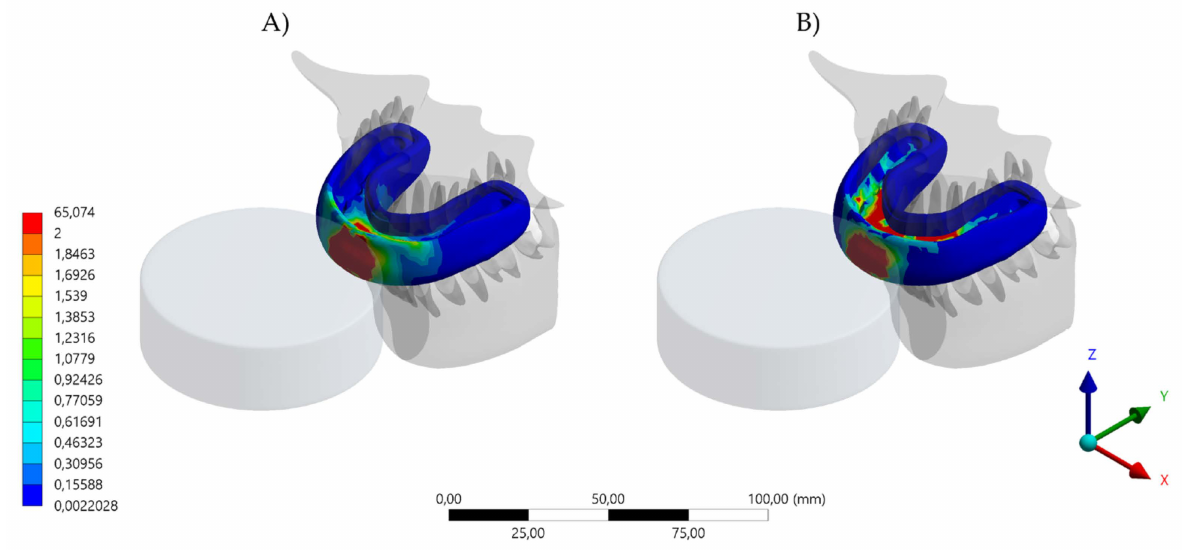
Figure 5. Von Mises Stress result in the MG. ( A ) Device stress with the conventional design and ( B ) device stress with the hybrid (HMG)